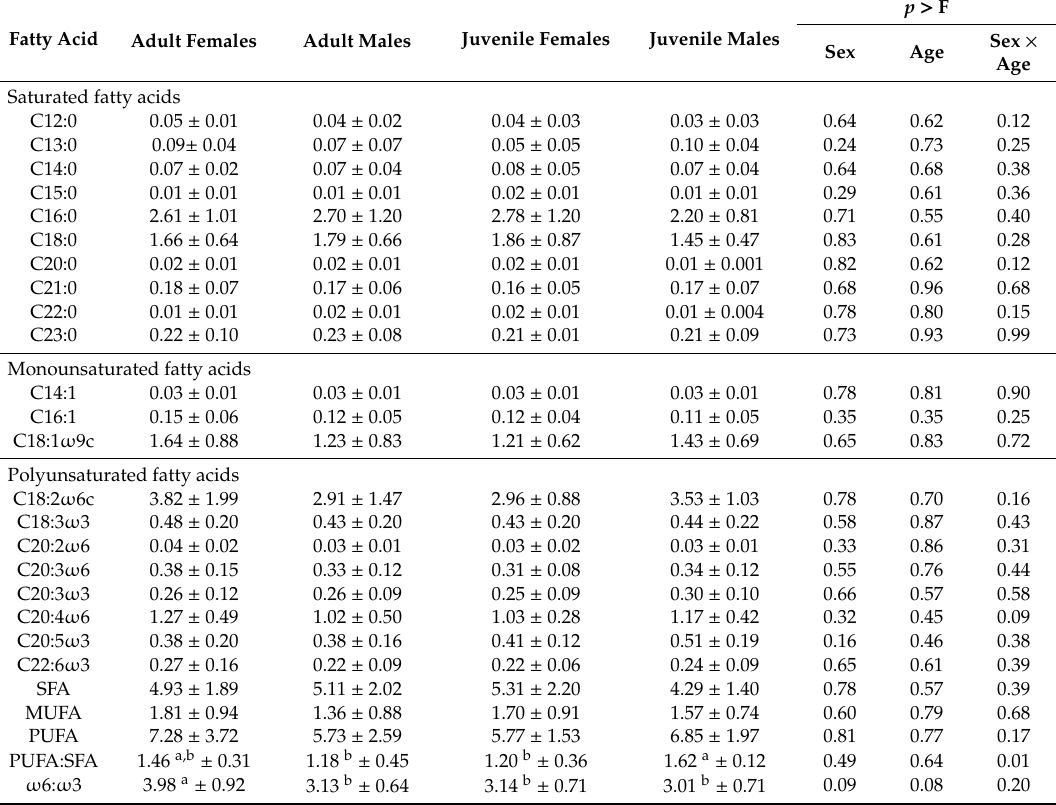
Table 6. The average mg / g ( ± SD) of the fatty acid composition of cooked warthog back bacon according to age and